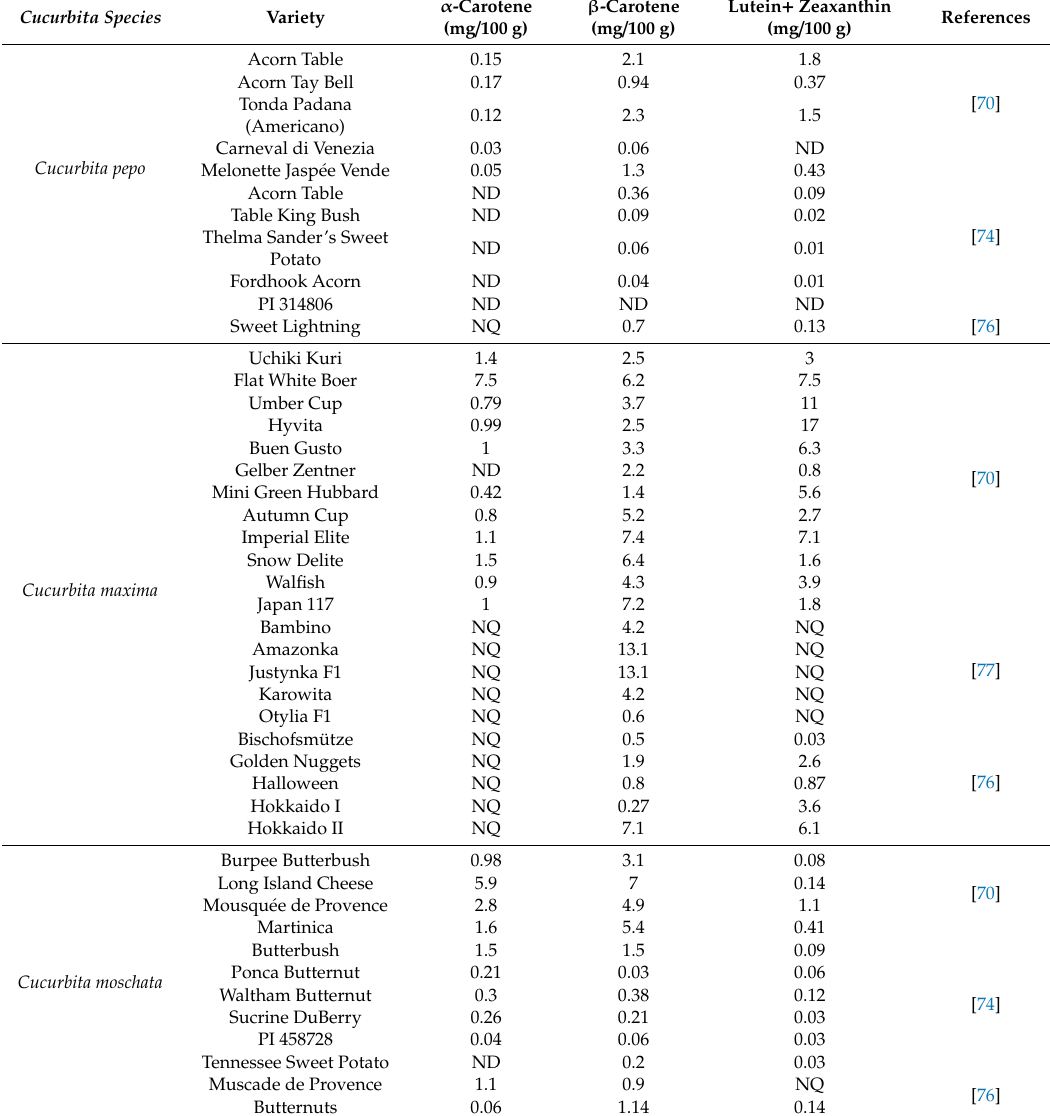
Table 3. Content of major carotenoid present in the edible flesh of Cucurbita spp. varieties *. Cucurbita